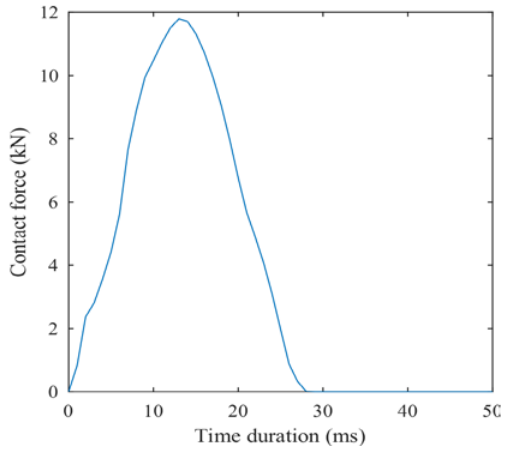
Fig. 7 Results of numerical simulations. Contact force time-history for impact location case 1.